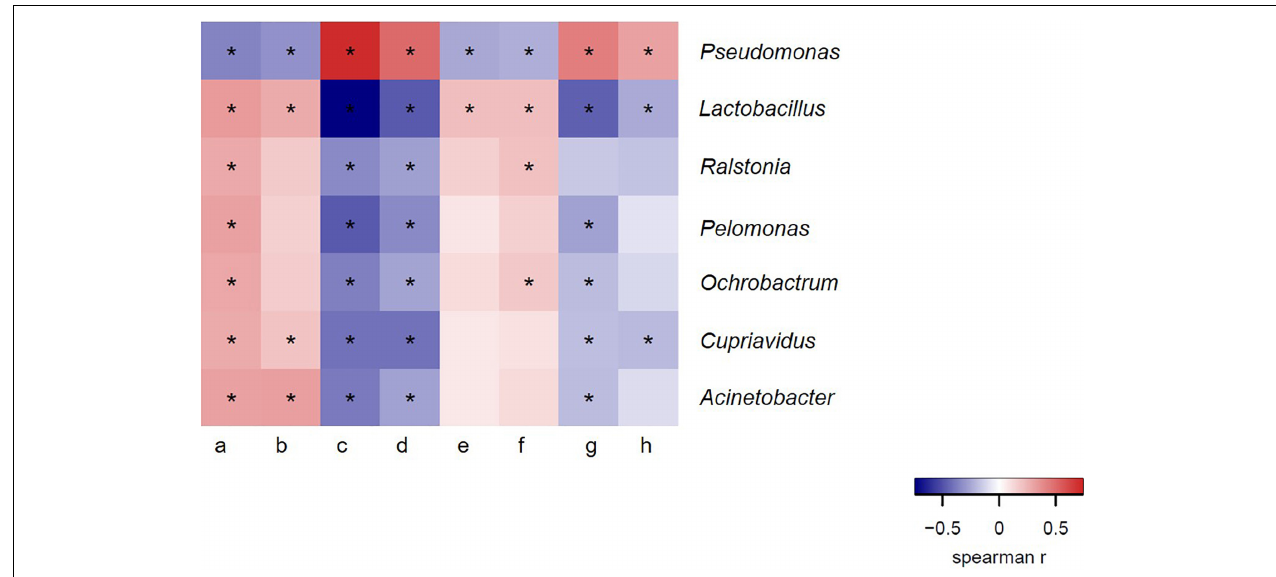
FIGURE 6 | Spearman correlation coefficient between bacteria at genus level and semen quality, reproductive performances. a, sperm concentration; b, motility; c, sperm malformation rate; d, estrus returning rate; e, mean number of live offspring; f, mean litter size; g, mean number of stillbirth; h, mean number of weak offspring. The genera were sorted by their average relative contribution from high to low, and genera with the average relative contribution lower than 2% in both winter and summer groups or without significant variation of all breeds of boars are not shown. *Means significant correlation between bacteria and sperm reproductive potential ( P < 0.05).